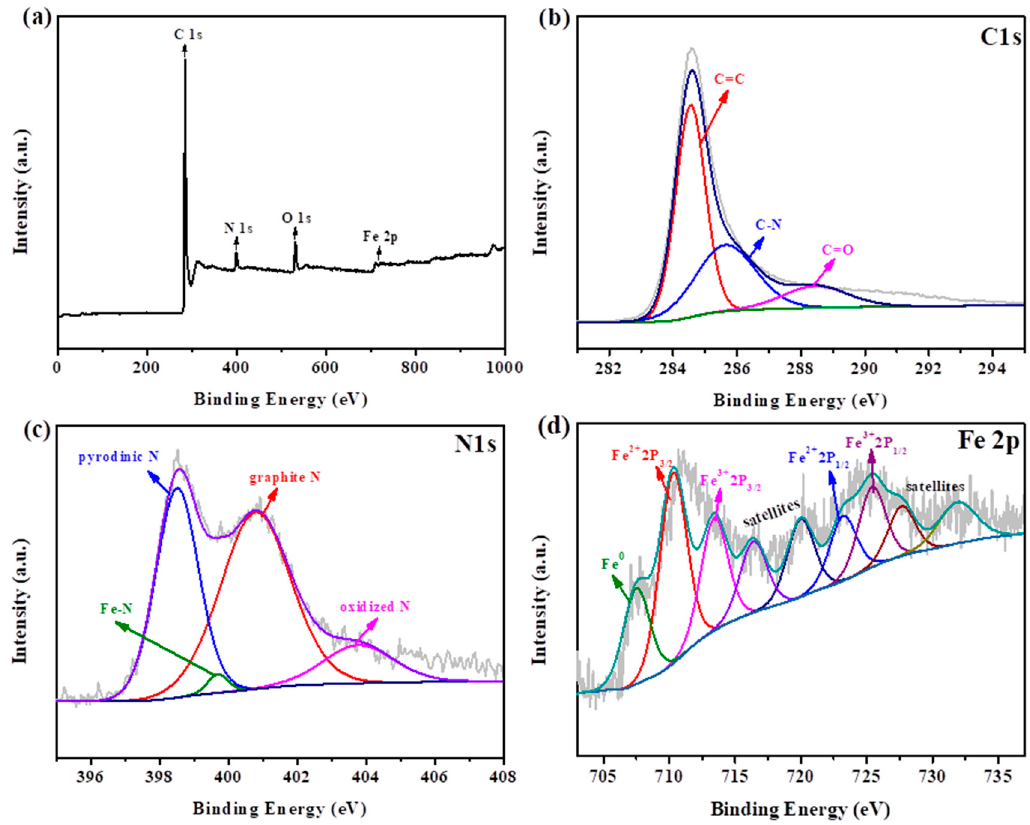
Figure 4. XPS spectra of N-Fe 3 C/rGO-H-100: ( a ) survey spectra, ( b ) C 1s, ( c ) N 1s and ( d ) Fe 2p.